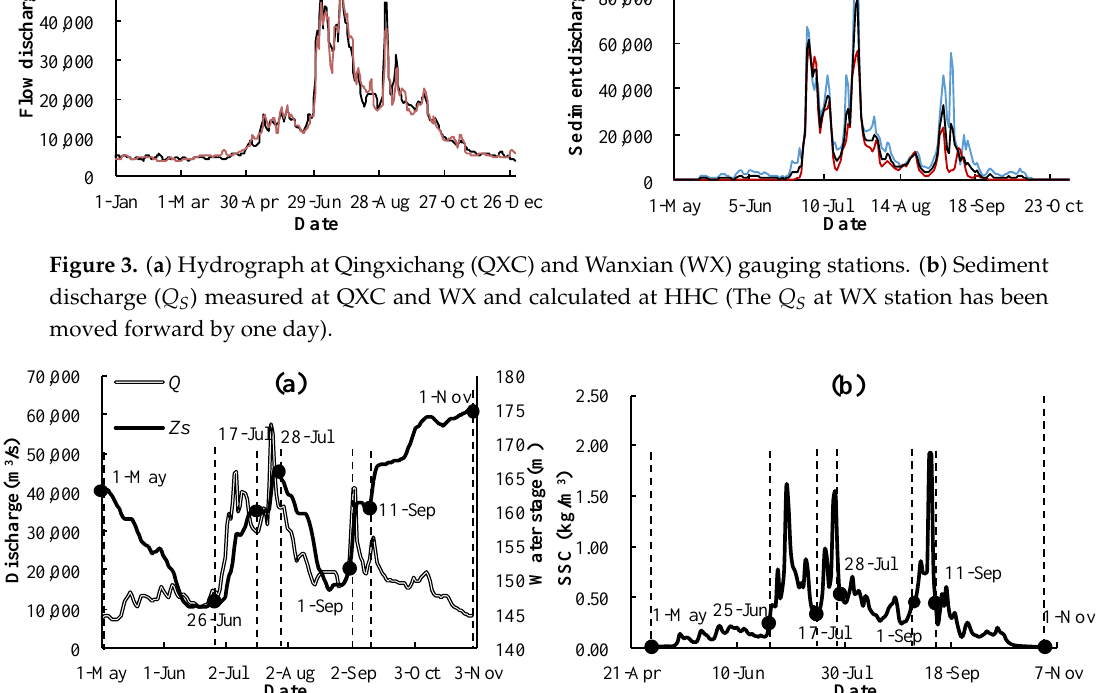
Figure 4. ( a ) Hydrograph and water stage from May 1 to November 1 ( Q and Z S represent discharge and water stage, respectively); the black filled circles divide the duration into several periods descripted clearly by the vertical black dash lines. ( b ) Suspended sediment concentration (SSC) as the inlet boundary in this duration.